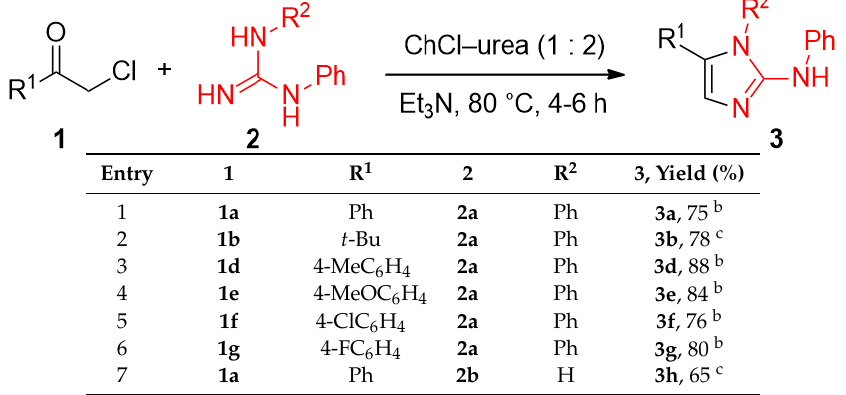
Table 2. Preparation of 2-aminoimidazole 3a,b,d – h directly in a ChCl–urea (1:2) eutectic mixture a